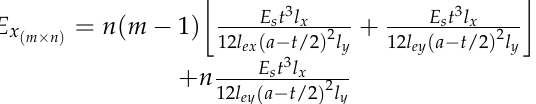
Table 1. Comparison of the results of theoretical derivations and FEM simulations.